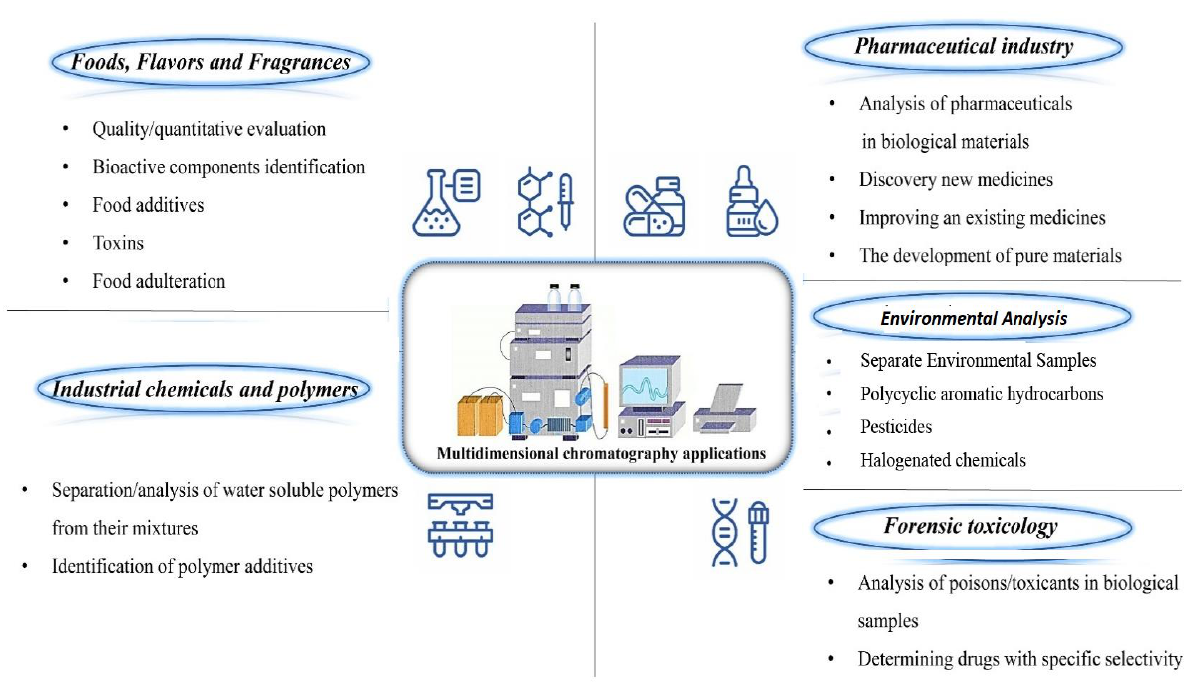
Figure 1. Representative scheme with the most important applications of multidimensional chro- matography. Table 1. Utilization of multidimensional chromatography in food products, biological samples, in- dustrial, environmental, and toxins.